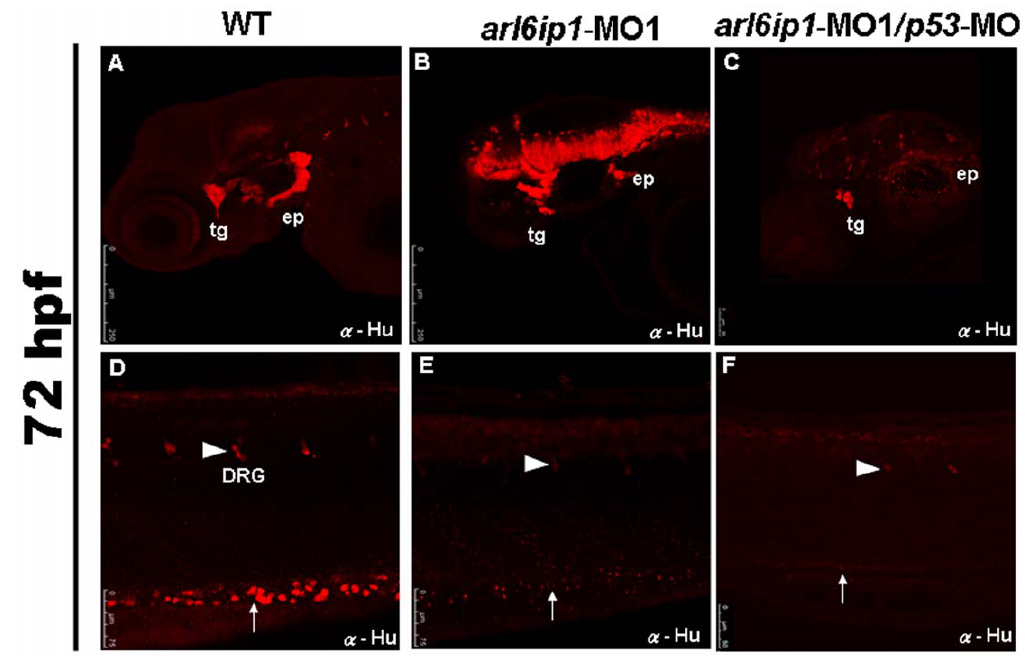
Figure 3. Neural crest derivatives are reduced in arl6ip1 -deficient embryos. Lateral views (A–F) of 72 hpf embryos processed for anti-Hu immunofluorescence assaying (IFA) to reveal the derivatives of cranial neural crest cells by confocal micrographs. In control embryos (A, D), anti-Hu IFA-labeled trigeminal ganglia (tg), epibranchial ganglia (ep), dorsal root ganglia (drg) (arrowhead), enteric neurons (arrow) all appeared to be reduced either in arl6ip1 knockdown embryos (B, E) or arl6ip1 -MO1 /p53 -MO-injected embryos (C, F).